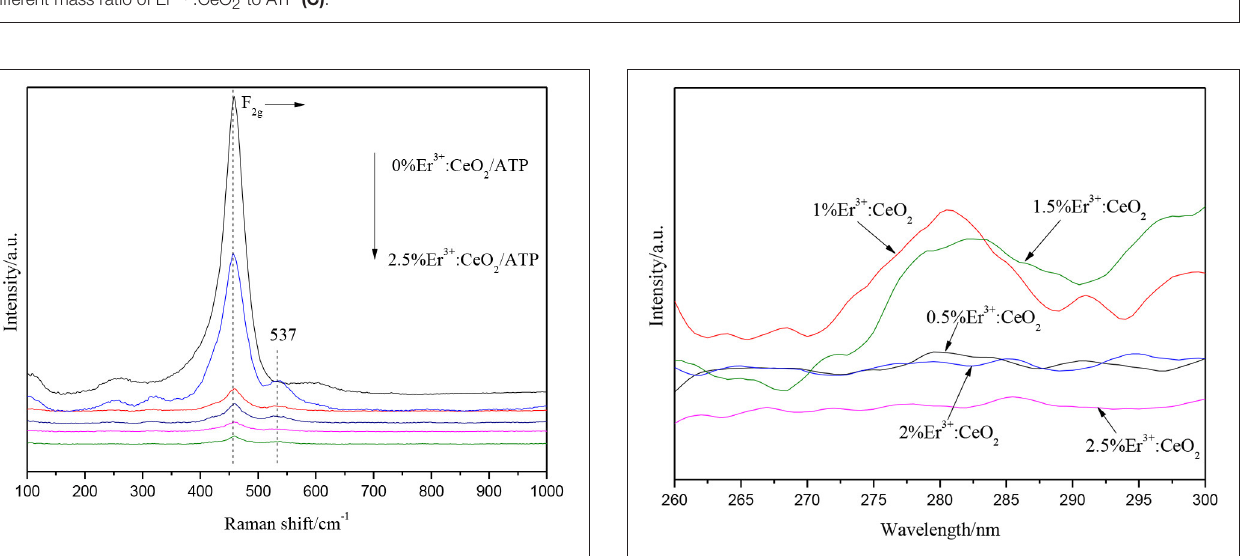
may be due to the small doping amount of Er. In Figure 1B , the characteristic peak at 28.55 ◦ shows slight shift to higher Bragg angle, implying that the Er 3 + dopant results in the lattice